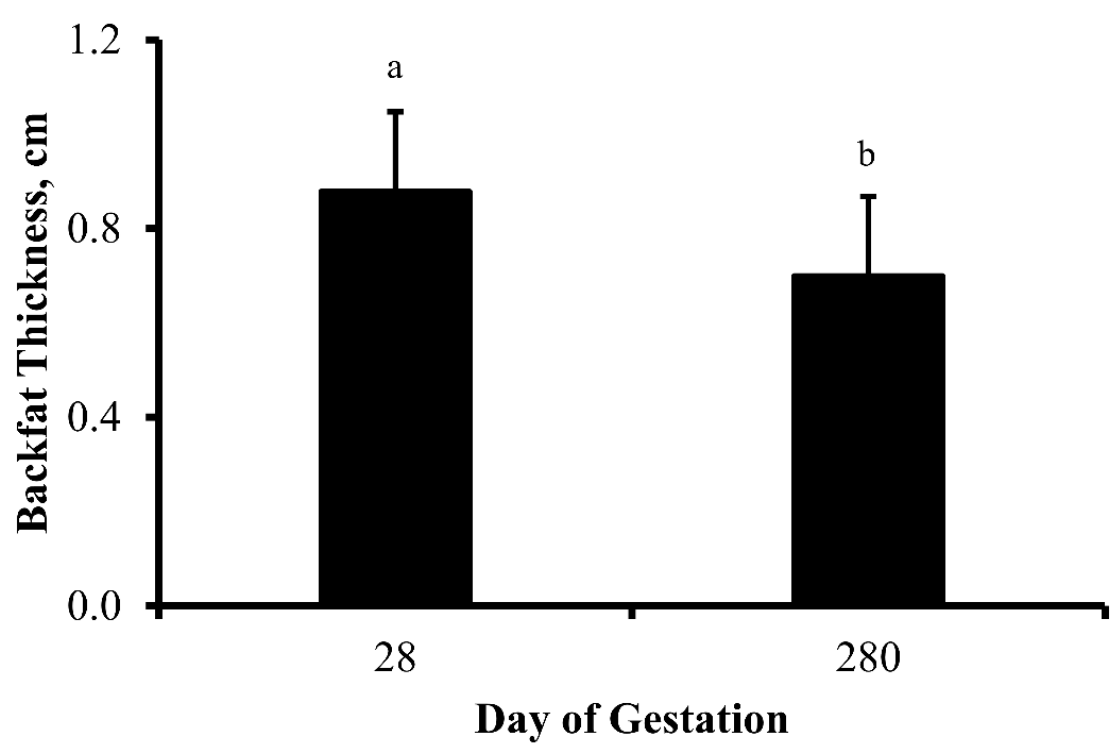
Figure 3. Backfat thickness (cm; least square means + SEM) of multiparous cows on day 28 and 280 of gestation. Dietary treatments were: Control (0 g urea/animal/day) or Urea (80 g urea/animal/day). Treatments were offered from day 28 of gestation to parturition. Backfat thickness did not change in response to treatment ( p = 0.74) or treatment by day interaction ( p = 0.65). However, backfat thickness decreased ( p = 0.02) in response to the progression of gestation. a,b Days with different lower case letters are different ( p ≤ 0.02).